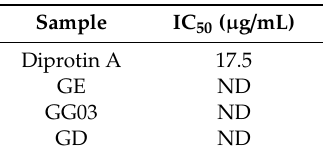
Table 2. Inhibitory e ff ects of GE, GG03 and GD on DPP-IV.